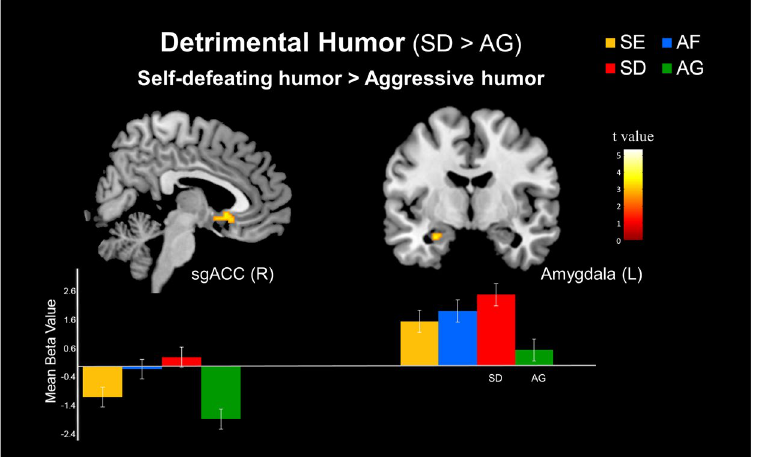
Figure 3. Simple effects of the differential neural mechanisms related to detrimental humor. (Top) Stronger responses to self-defeating humor (SD) than to aggressive humor (AG) in the right subgenual anterior cingulate cortex (sgACC) and left amygdala. (Bottom) Parameter estimates (SPM betas) are plotted for the two regions. Standard error bars are shown.